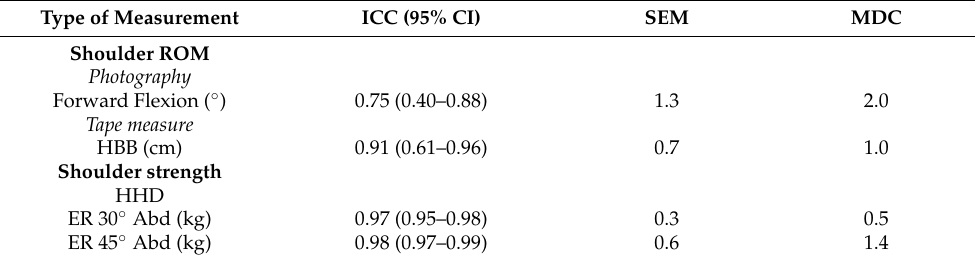
Table 4. Inter-rater reliability (n =